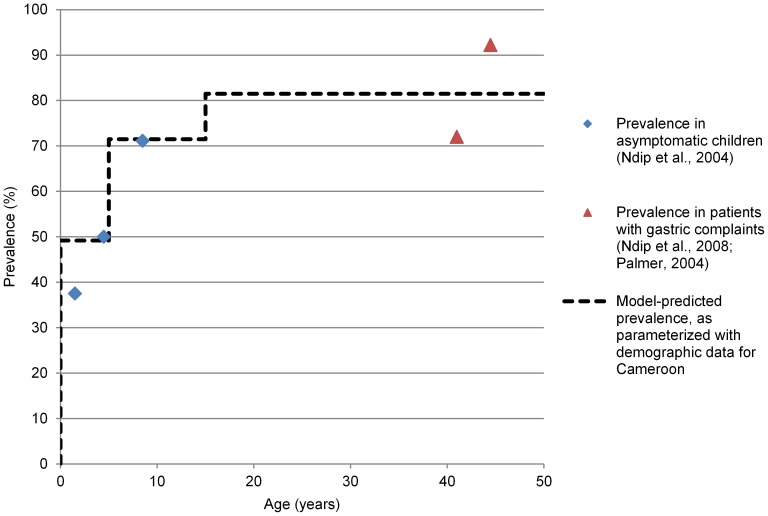
Model predicted prevalence under the base scenario versus observed H. pylori prevalences by age in Cameroon.The model-predicted prevalence rises in steps with the three age classes (i.e., child, youth, adult).